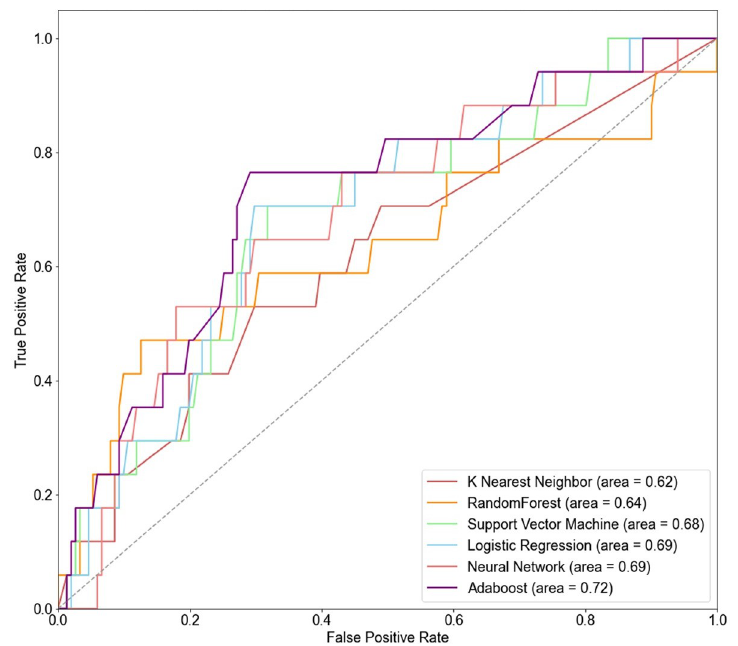
Fig 3. ROC curves of six different machine learning